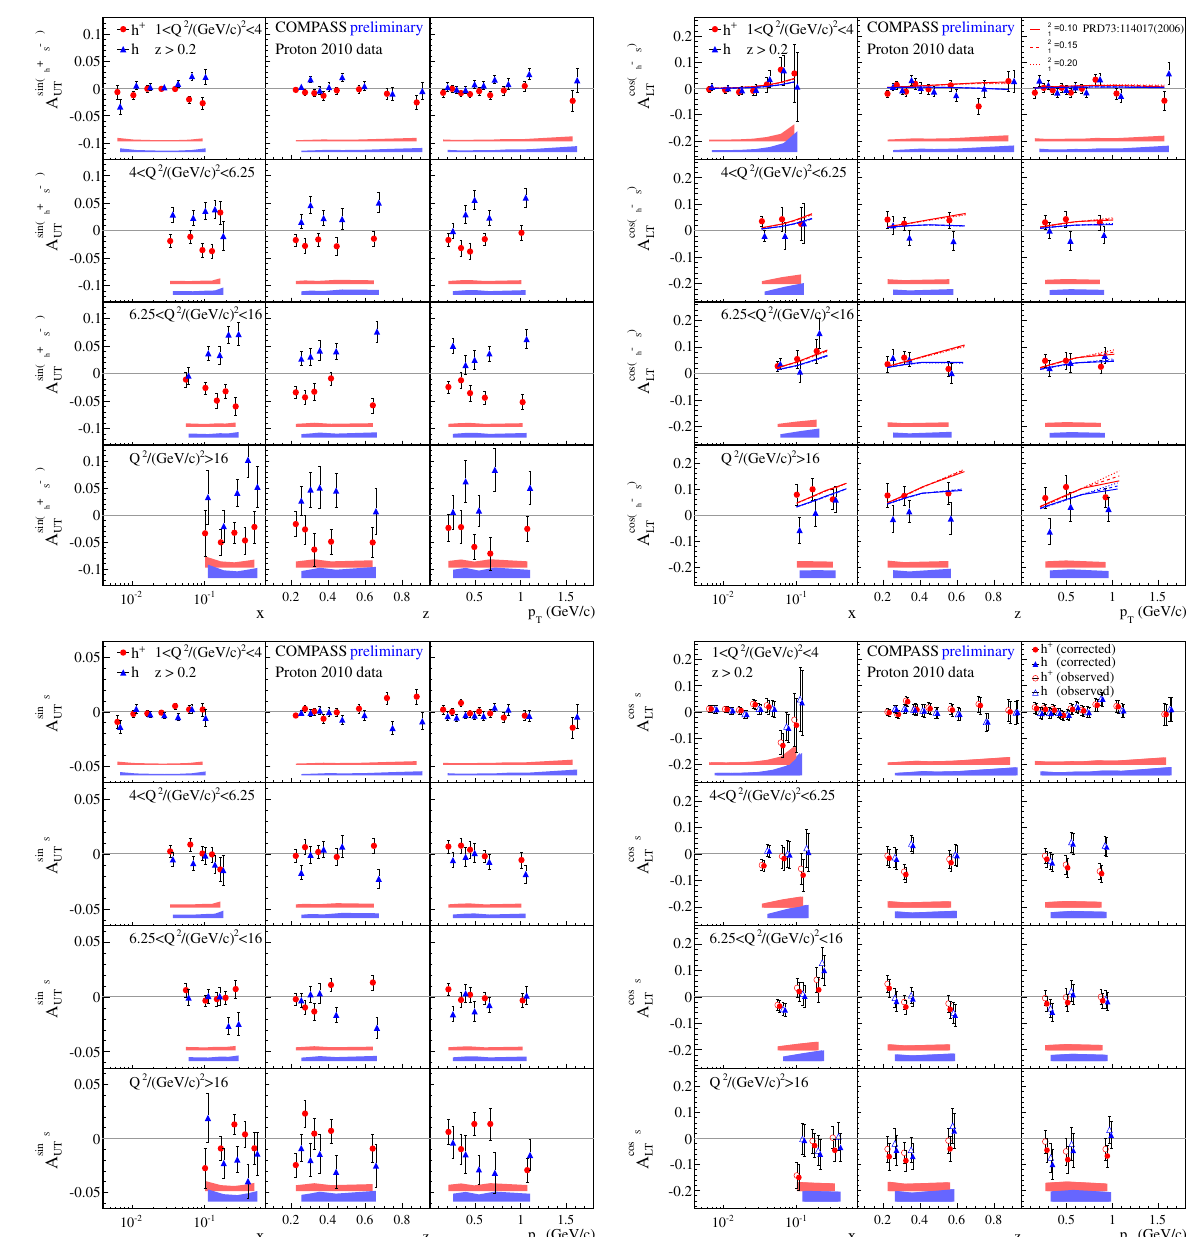
Figure 6. Collins (top) and A sin φ S